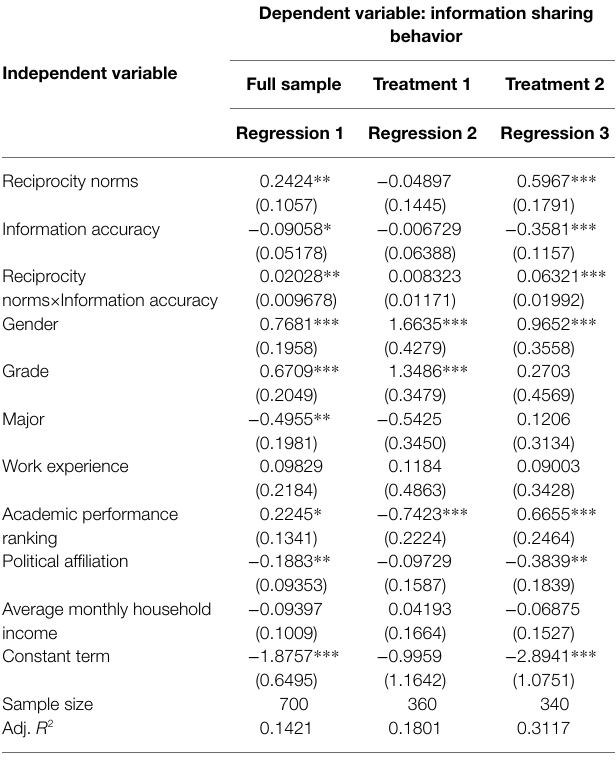
TABLE 7 | Information accuracy, reciprocity norms, and information sharing behavior.